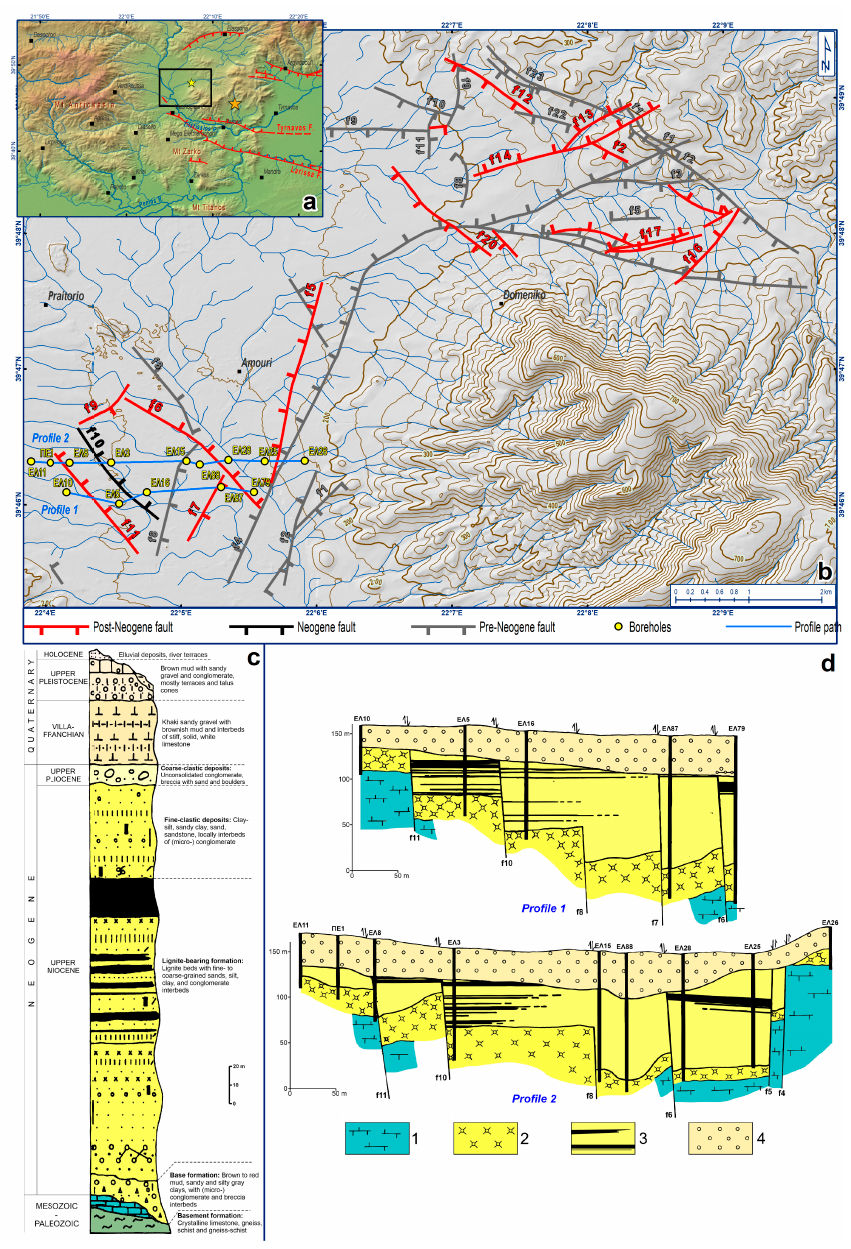
Figure 5. ( a ) Hillshade map of the broader 2021 epicentral area showing the epicentres of the strongest shocks (orange star = March 3, M w 6.3, yellow star = March 4, M w 6.0), and the neotectonic faults according to literature (for references see main text). ( b ) Shaded relief map exported from the 5 m-DEM of Hellenic Cadastre where the fault locations suggested by IGME’s study are shown [50]. The location of selected boreholes and the profile paths of inset ( d ) are also shown. ( c ) Synthetic stratigraphic column of the Neogene formations of the Elassona Basin, according to the above study (after Dimitriou and Giakoupis [50] modified). ( d ) Interpreted profiles based on borehole data [50]. Lithology is simplified: 1 = alpidic basement, 2 = base formation (Upper Miocene), 3 = lignite-bearing formation with the fine- and coarse-clastic deposits (Upper Miocene-Villafranchian), 4 = Quaternary deposits (Upper Pleistocene-Holocene). After Galanakis et al.